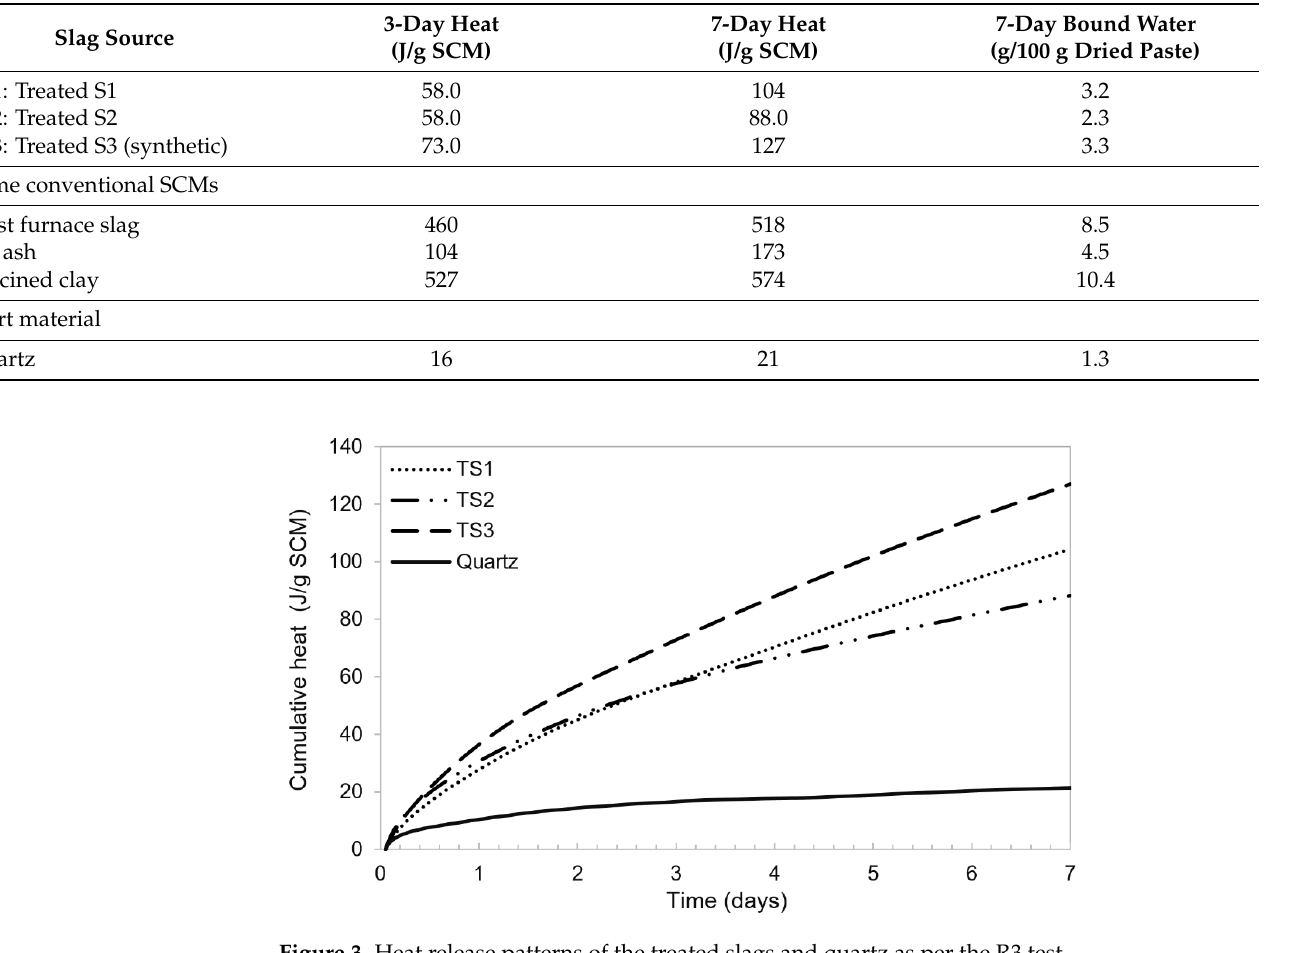
Figure 3. Heat release patterns of the treated slags and quartz as per the R3 test. Table 7. R3 test results for the slags, along with some conventional SCMs and inert quartz.